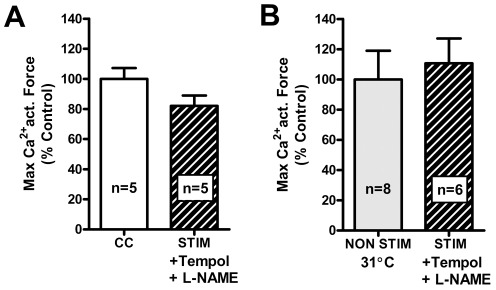
Tempol and L-NAME help prevent the decrease in Fmax.
A: Mean relative Fmax (+s.e.m) in fibers from non-stimulated contralateral SOL muscle (‘CC’, open bar) and SOL muscle stimulated in vitro in presence of 1 mM Tempol and 3 mM L-NAME (dashed bar) (all values expressed as a percentage of average of that in CC fibers recorded in same experiment). No significant difference in Fmax between the two cases. B: Similar mean Fmax data for fibers from muscles stimulated with Tempol and L-NAME present (dashed bar) and fibers from the contralateral muscles bubbled with 95% O2 at 31°C for same period (gray bar). No significant difference in Fmax between the two cases.